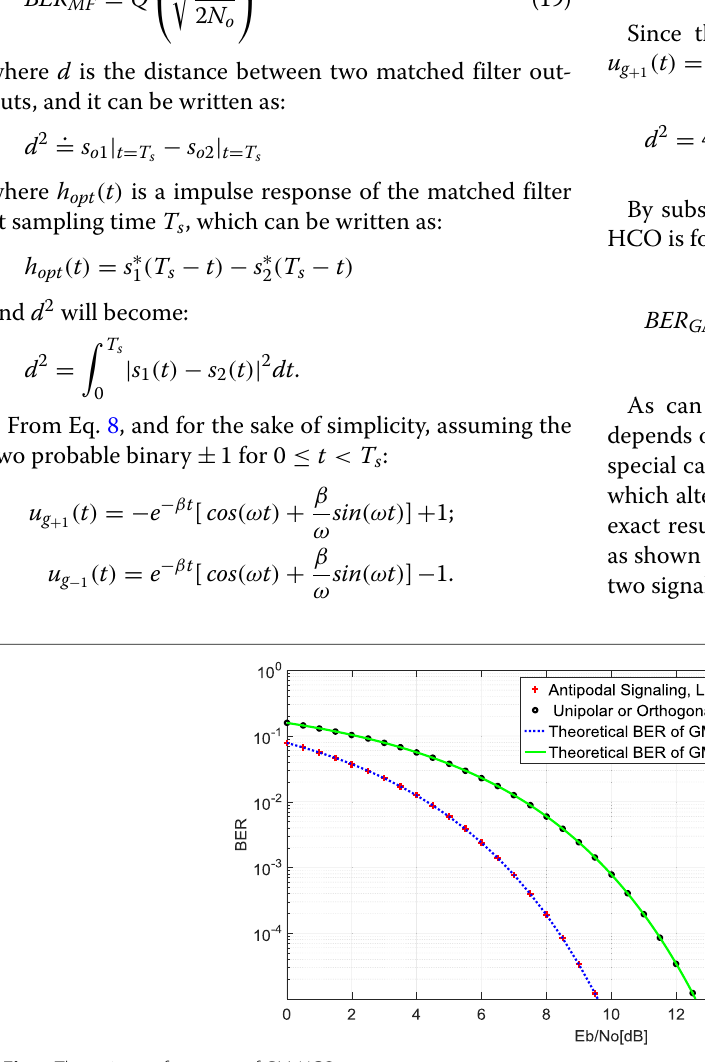
Fig. 5 The noise performance of